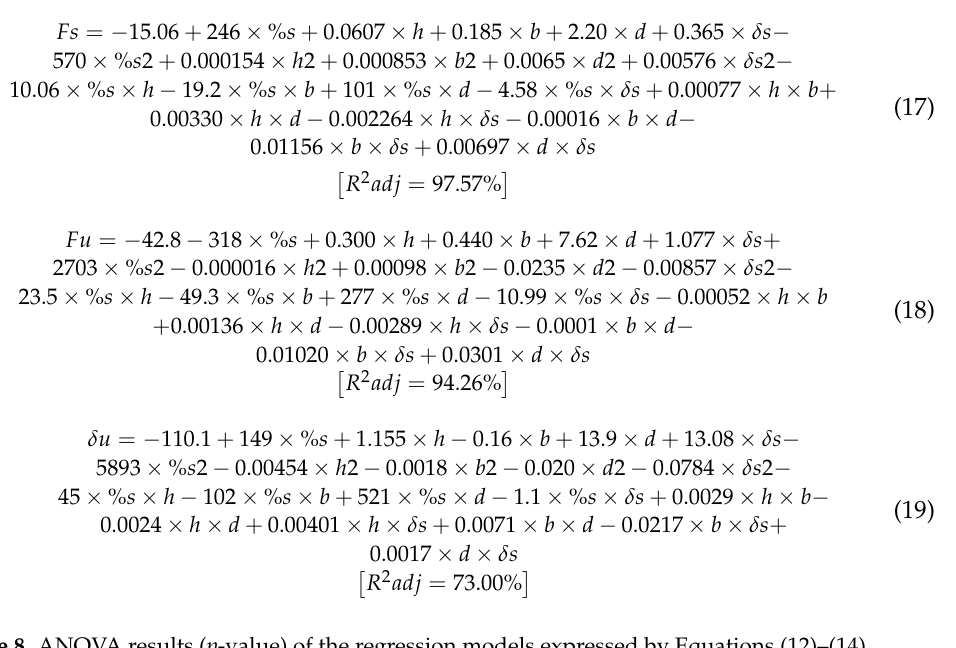
Table 8. ANOVA results ( p -value) of the regression models expressed by Equations